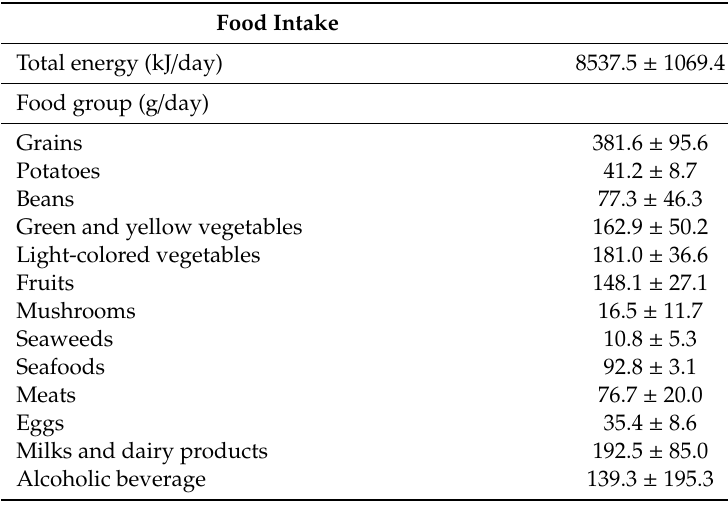
Table 2. Habitual dietary food intake of the subjects in this